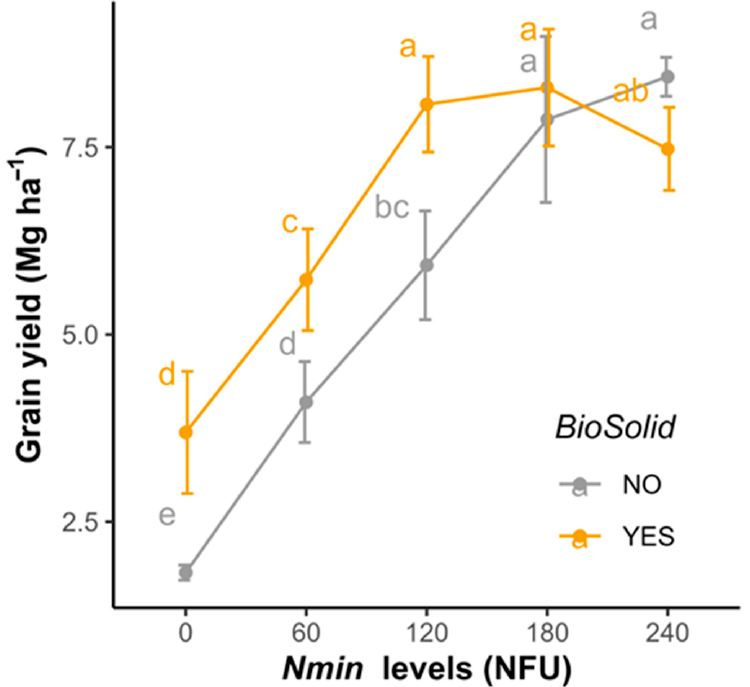
Figure 1. Grain yield (Mg ha − 1 ) as a function of the Nmin and BioSolid levels. Treatments with the same letter are not significantly different ( α = 0.5). Error bars show 1 standard deviation of 4 replicated data.